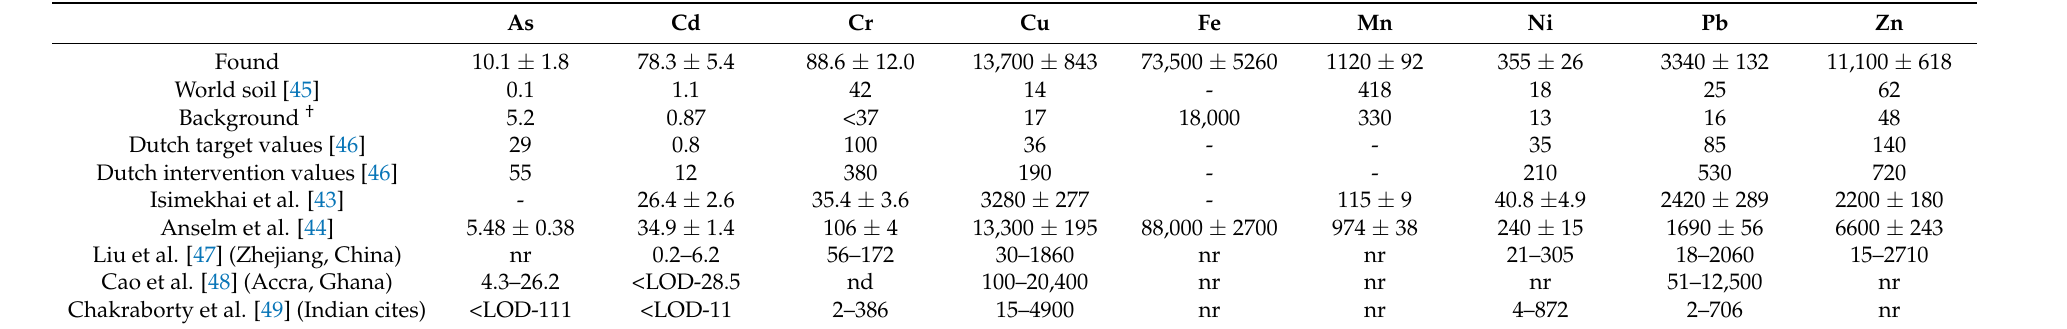
Table 3. Analyte concentrations in the bulk composite soil sample from the Alaba e-waste recycling site (mg/kg dry weight, n = 3) and comparison with reference and selected recent literature